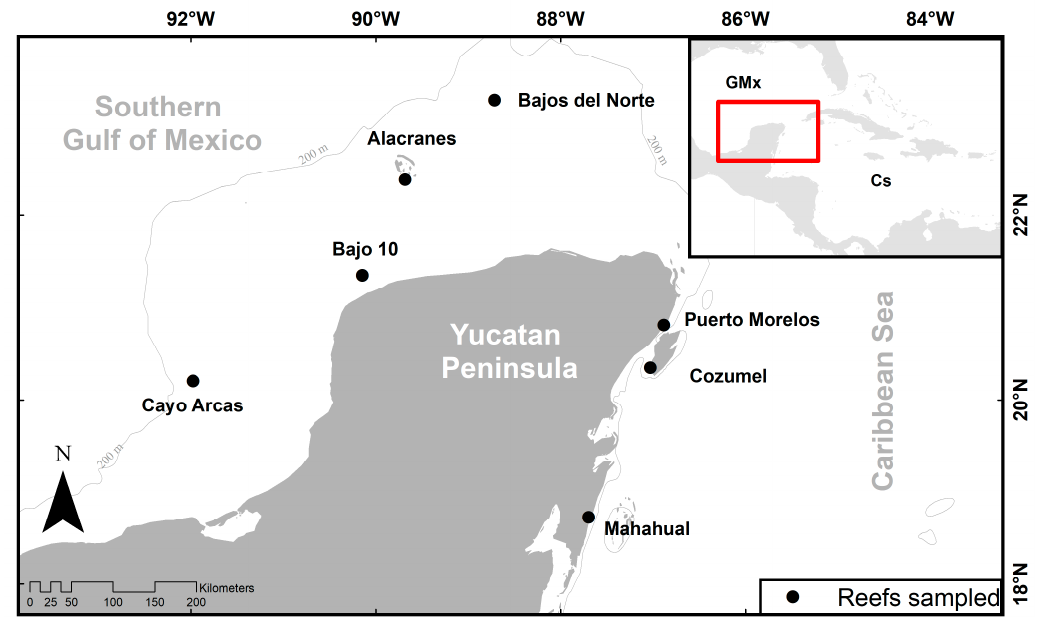
Figure 1. Sampled Reefs in the region of the Mexican Caribbean Sea (Cs) and the southern Gulf of Mexico (GMx) included in the red rectangle shown in the insert. Bathymetry line at a depth of